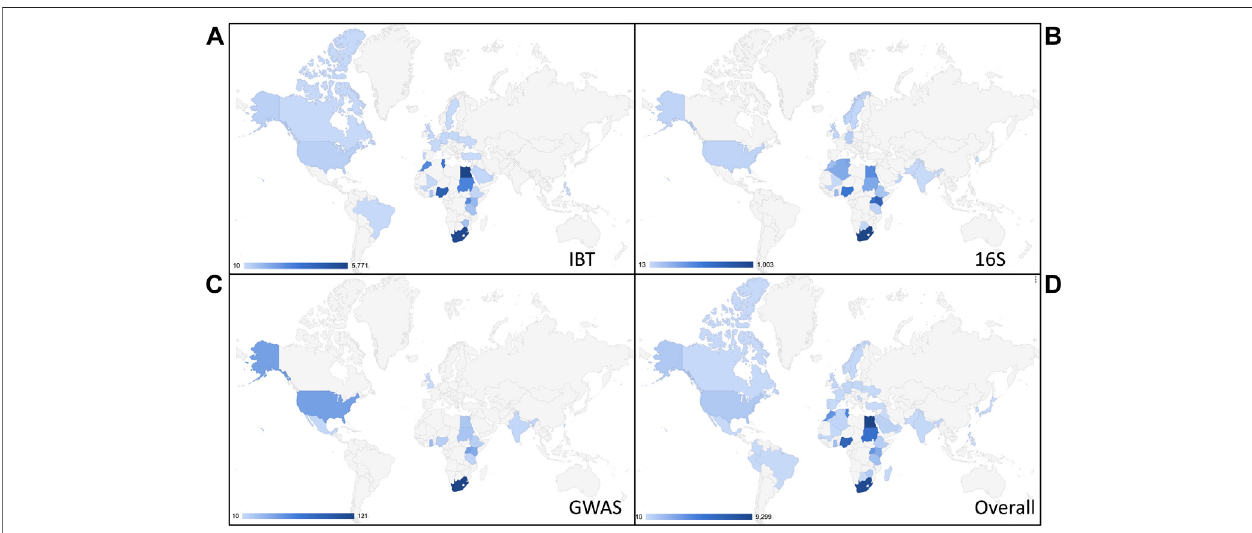
FIGURE8| Geographicallocations(countries)whereH3ABioNetYouTubeplaylistsarebeingaccessedfromforthe (A) IntroductiontoBioinformaticsTraining(IBT) playlist, (B) 16 S rRNA data analysis Intermediate Bioinformatics Training Course (IntBT) playlist, (C) Genome Wide Association Study (GWAS) playlist and (D) H3ABioNet channel views overall. Maps do not depict views from countries with a total number of views < 10 and represent the number of overall playlist views (clicks). Individual video views and analytics will thus differ. Colour scales on the maps represent the actual number of playlist